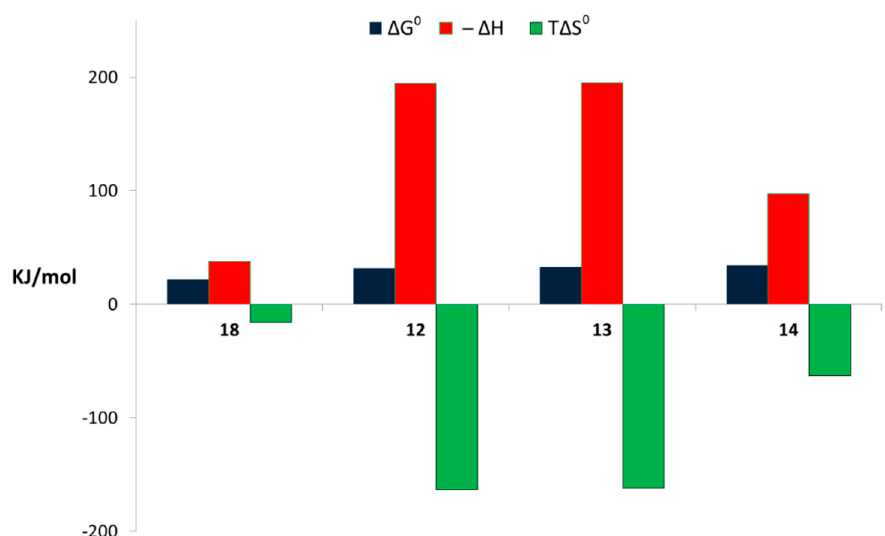
Figure 4. Free energy ( − ∆ G 0 , black), enthalpy ( − ∆ H , red), and entropy changes ( T ∆ S 0 , green) for the binding of Fc-Lac dendrimers 12 – 14 and monovalent glycoconjugate 18 to Gal-3 obtained from isothermal titration calorimetry (ITC) experiments in 20 mM phosphate buffer at pH 7.2 with 150 mM NaCl at 25 °C.